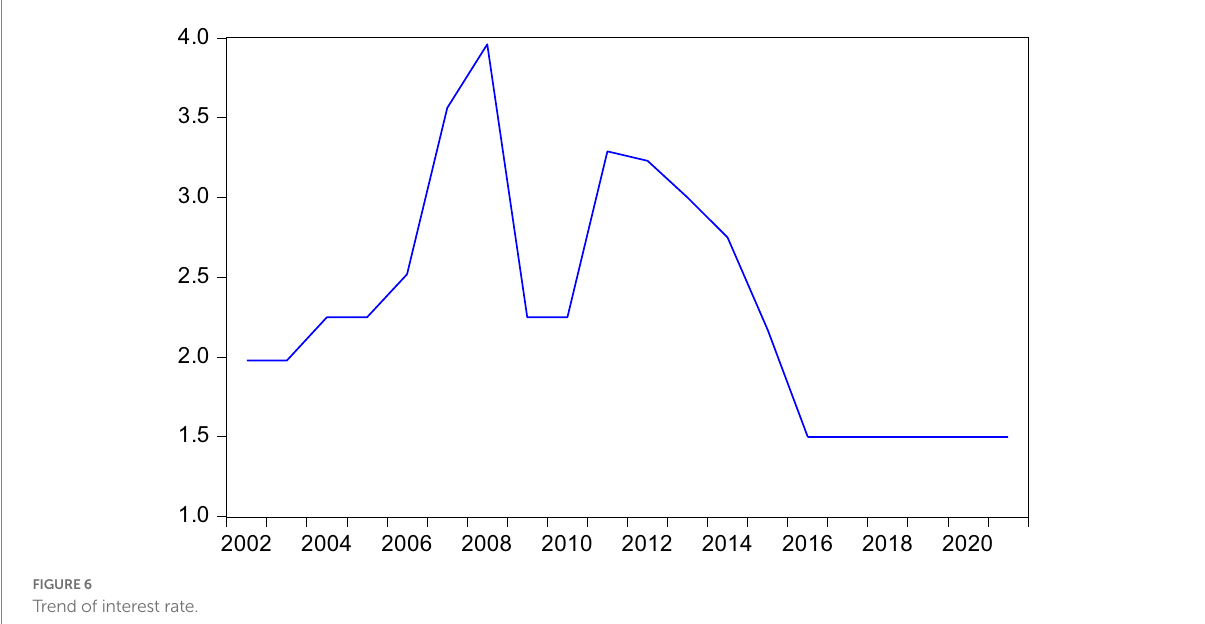
FIGURE 5 Trend of expected inflation rate.